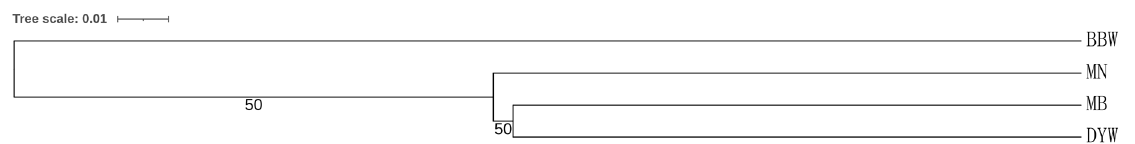
Figure 7. A UPGMA tree reconstructed based on Nei’s D A Distance among four populations in Epinephelus awoara . MN: Southern Fujian population; MB: Northern Fujian population; DYW: Daya Bay population; BBW: Beibu Gulf population.